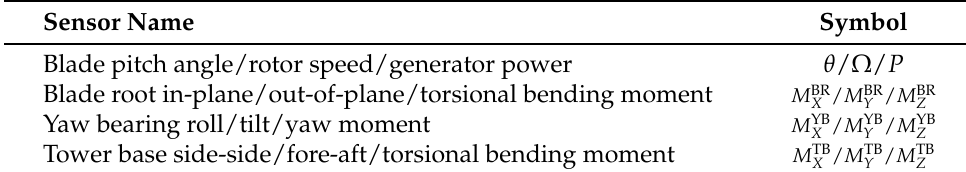
Table 5. Considered sensors for turbulent wind